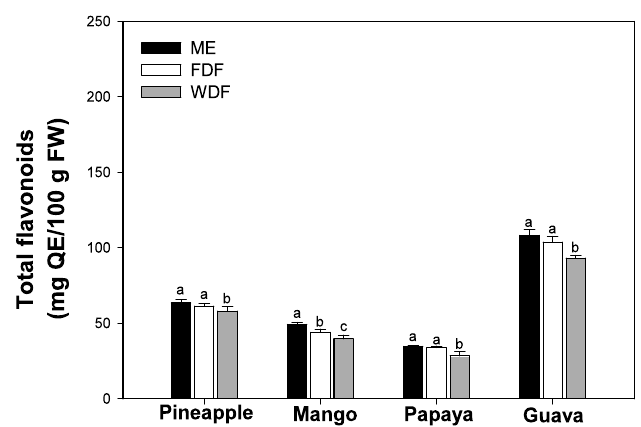
Fig. 2: Total flavonoids content of methanolic extracts of tropical fruits and reduction by adding fruit dietary fiber (FDF) and wheat dietary fi- ber (WDF). Different letter in bars indicates significant difference (p<0.05) among fiber types by fruit.